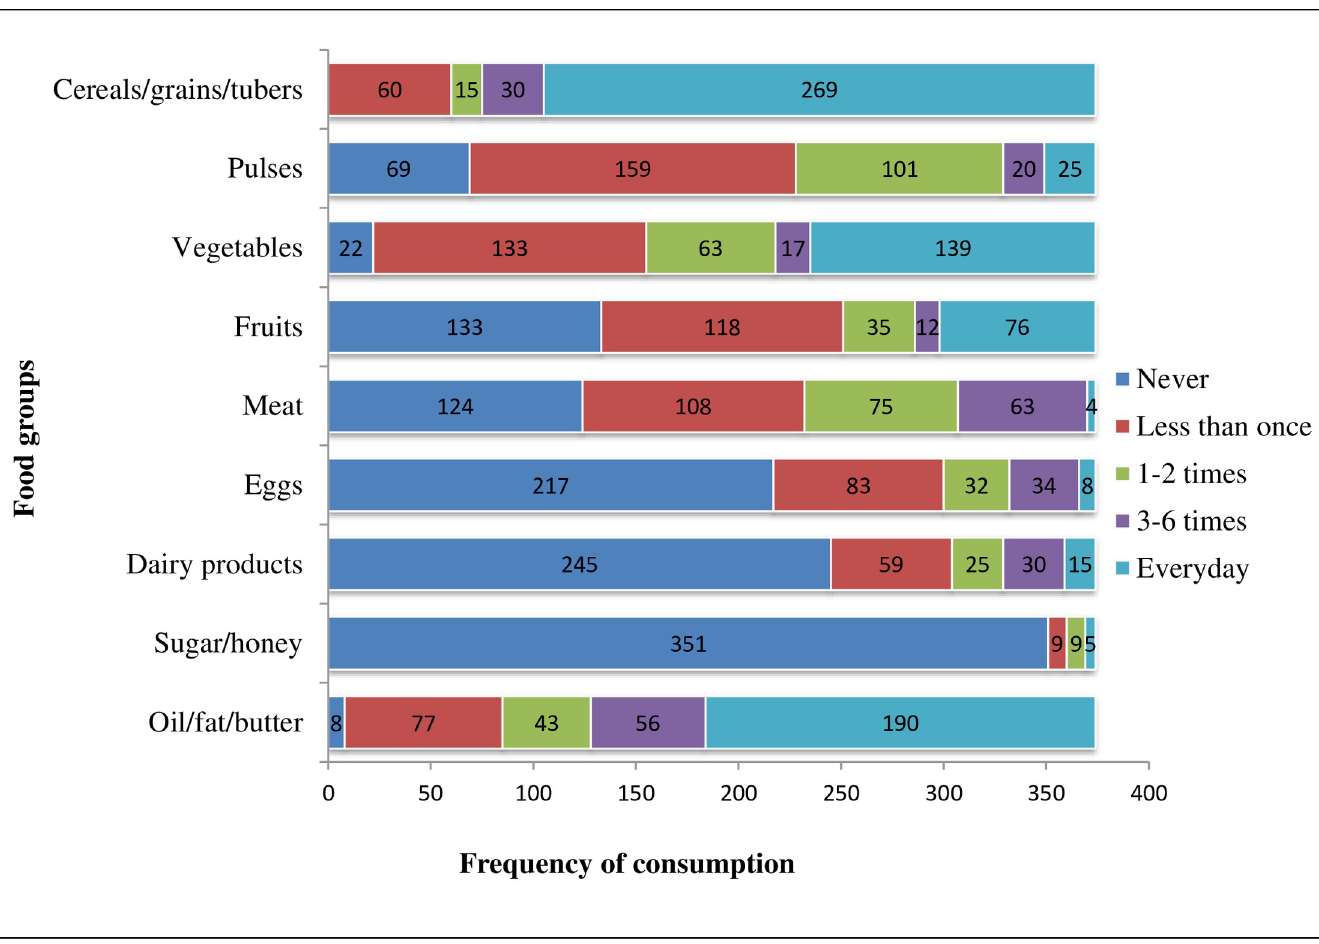
Fig 2. Consumption frequency of different food groups (per week) among T2DM patients attending public hospitals in Harari Region, Eastern Ethiopia, February to March 2019 (n =